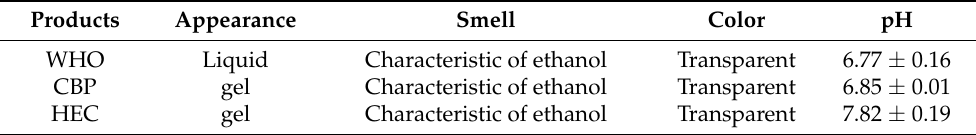
Figure 1. Graphical representation of the appearance of the three formulations object of the study: ( A ) formulation 1 (WHO); ( B ) formulation with carbopol (CBP); ( C ) formulation with hydroxyethyl- cellulose (HEC) provided by LEM Compounding Research S.r.l. Table 1. Organoleptic properties and pH of the three formulations object of the study (formulation 1 (WHO); formulation with carbopol (CBP) and formulation with hydroxyethylcellulose (HEC). Values of pH are the results of three independent measurements with relative SD.